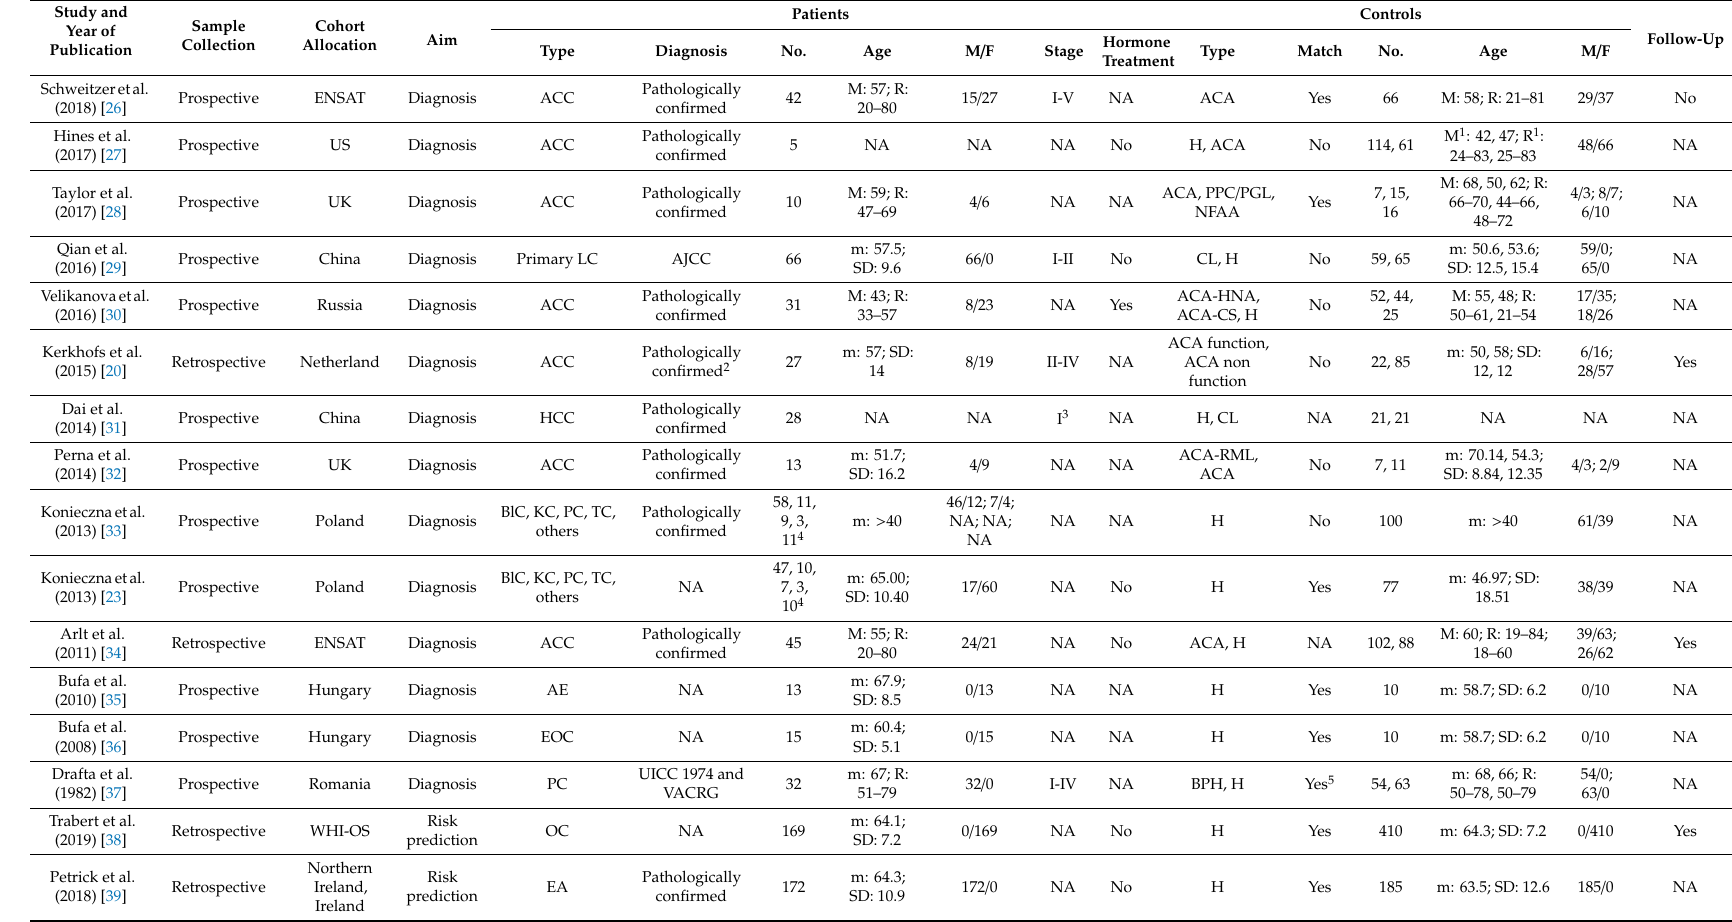
Table 1. Demographic characteristics of the included